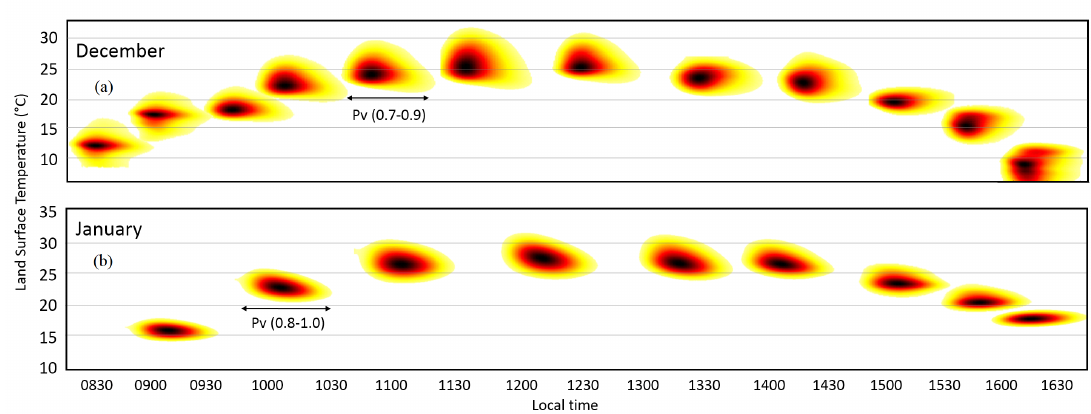
Figure 9. Diurnal cycles of pixel-based LST versus proportion of vegetation ( Pv ) between 830 and 1645 on 13 December 2016 ( a ) and 31 January 2017 ( b ). Distinct clusters represent the temperature distributions for each